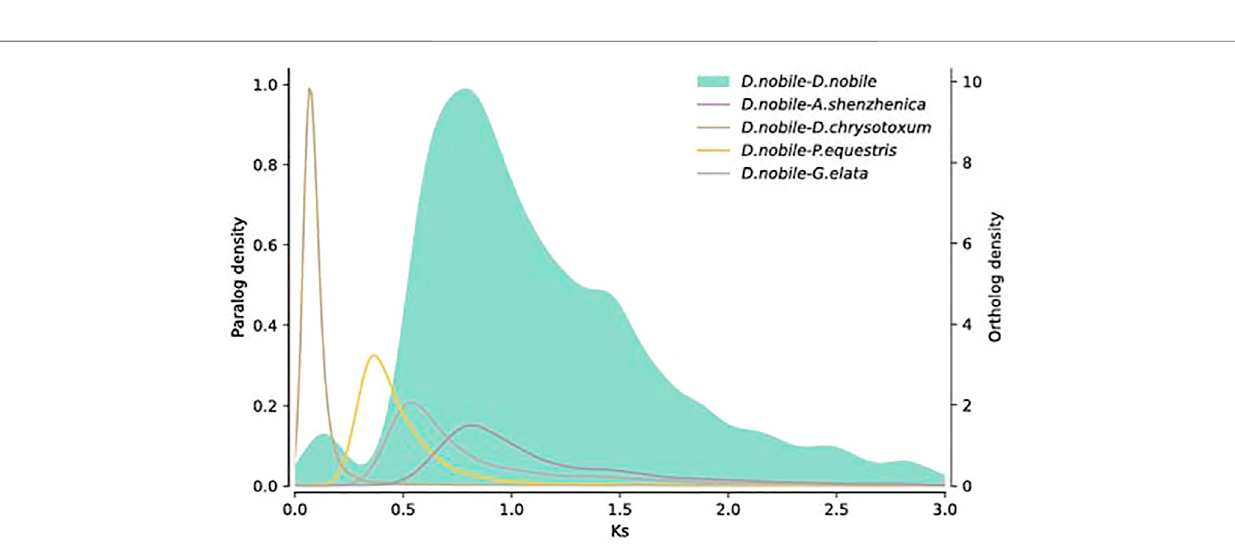
Frontiers in Genetics |